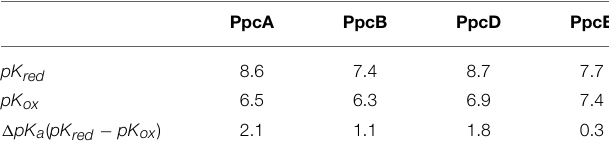
TABLE 2 | Macroscopic pK a -values of the redox-Bohr center for PpcA, PpcB, PpcD, and PpcE in the reduced ( pK red ) and oxidized states ( pK ox ) ( Morgado et al., 2010a). PpcA PpcB PpcD PpcE pK red 8.6 7.4 8.7 pK ox 6.5